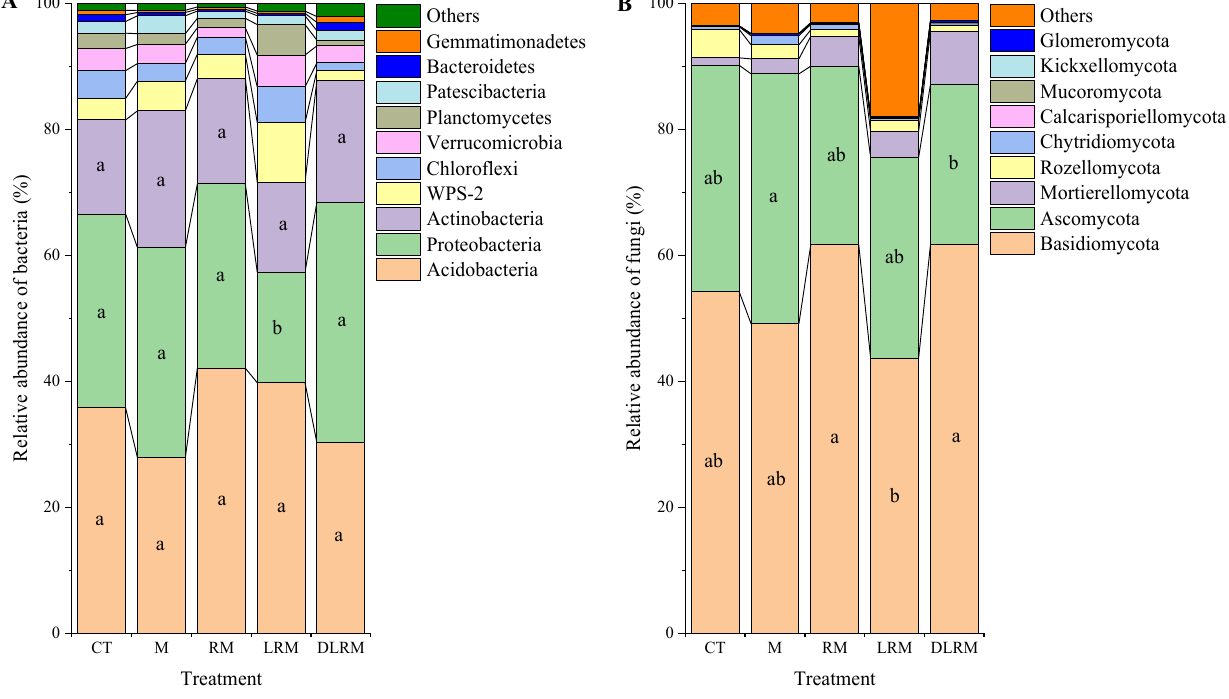
Figure 2. Relative abundance of major soil bacteria ( A ) and fungi ( B ) at phylum level in different treatments. Different lowercase letters indicate significant difference among treatments ( p < 0.05). Table 4. Relative abundance of major soil bacteria and fungi at class level in different treatments (%).